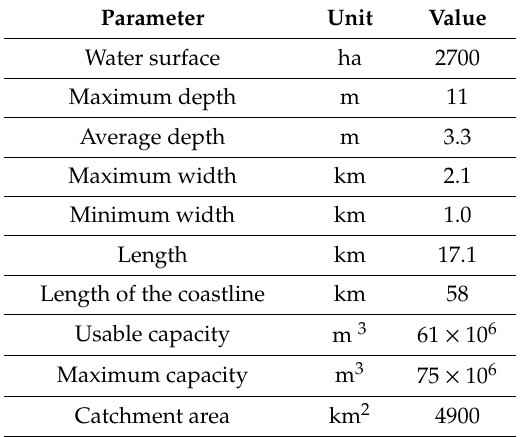
Table 1. Morphometric parameters of the Sulej ó w Reservoir.